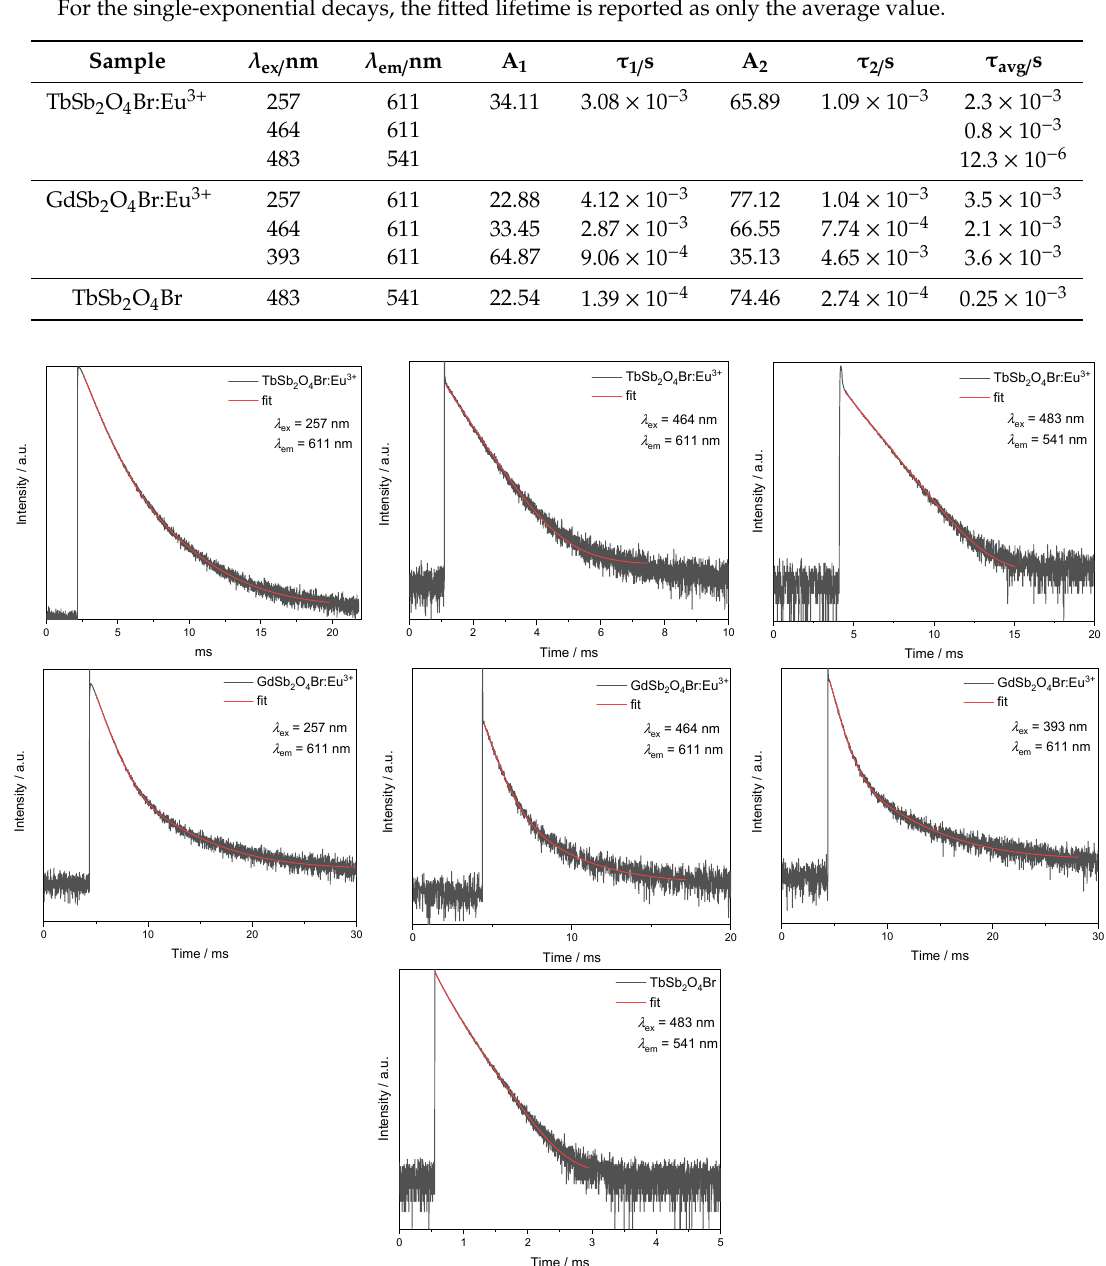
Figure A3. Intensity decay curves as measured (black) and fitted decay curves (red).